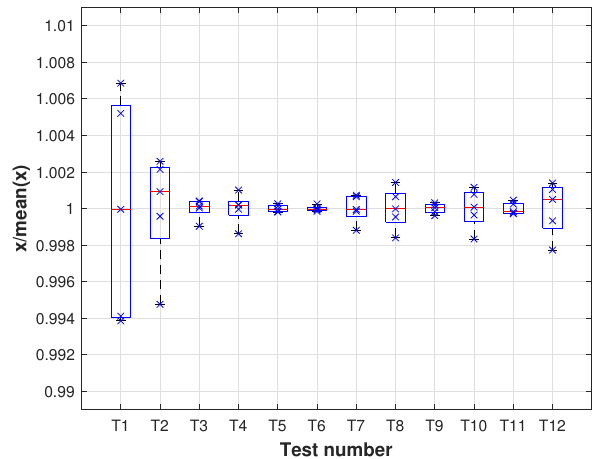
Figure 12. Repeatability results.